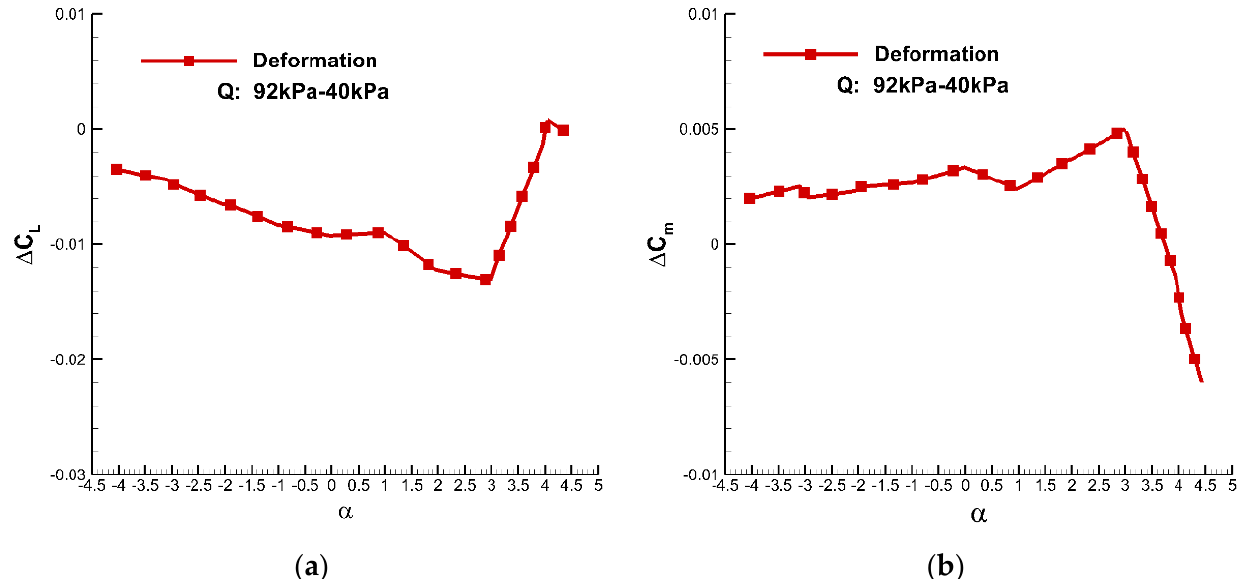
Figure 5. Increments of the lift and pitching moment coefficients caused by dynamic pressure variation (M = 0.76, Re = 15 × 10 6 ): ( a ) increments of the lift coefficient; ( b ) increments of the pitching moment coefficient.